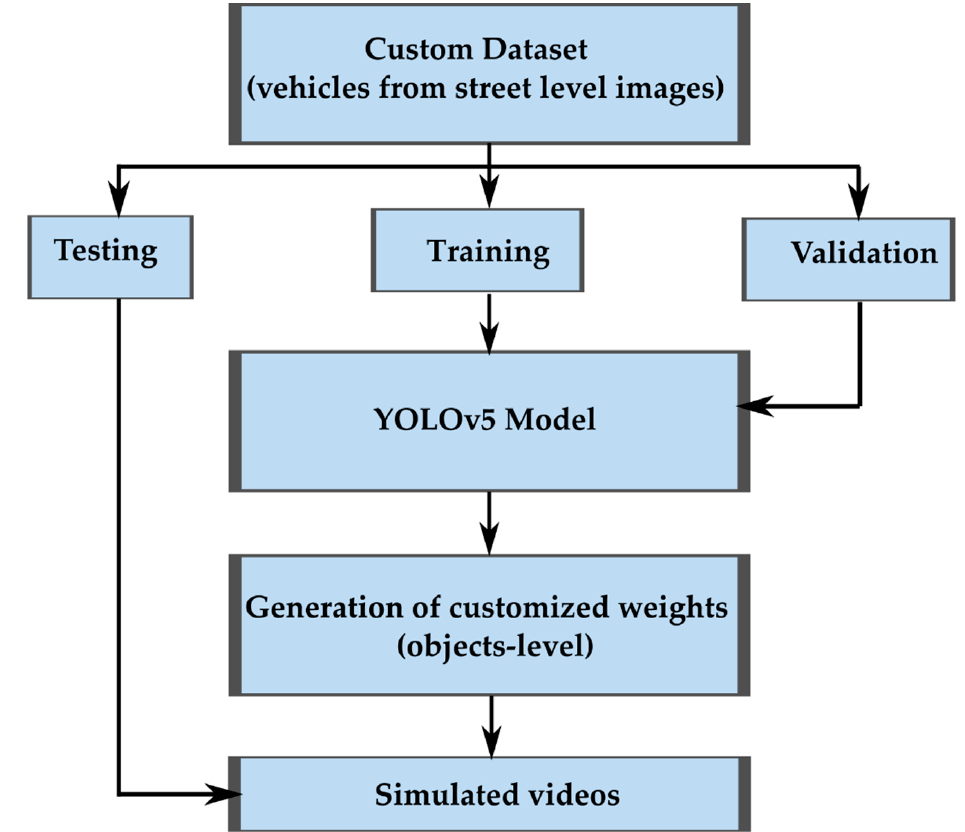
Figure 1. Object detection workflow using YOLOv5 model.